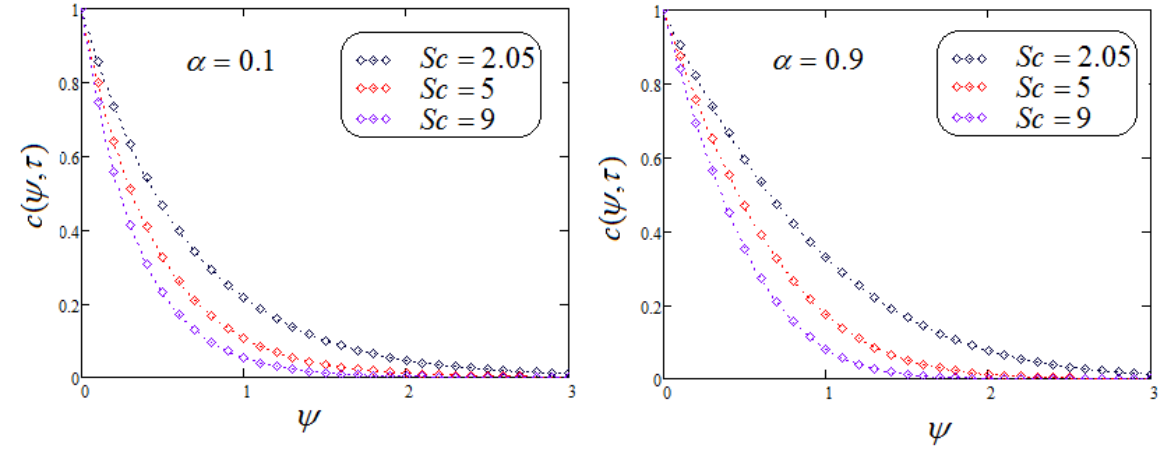
Figure 3. Trace of concentration for dissimilar values of Sc .